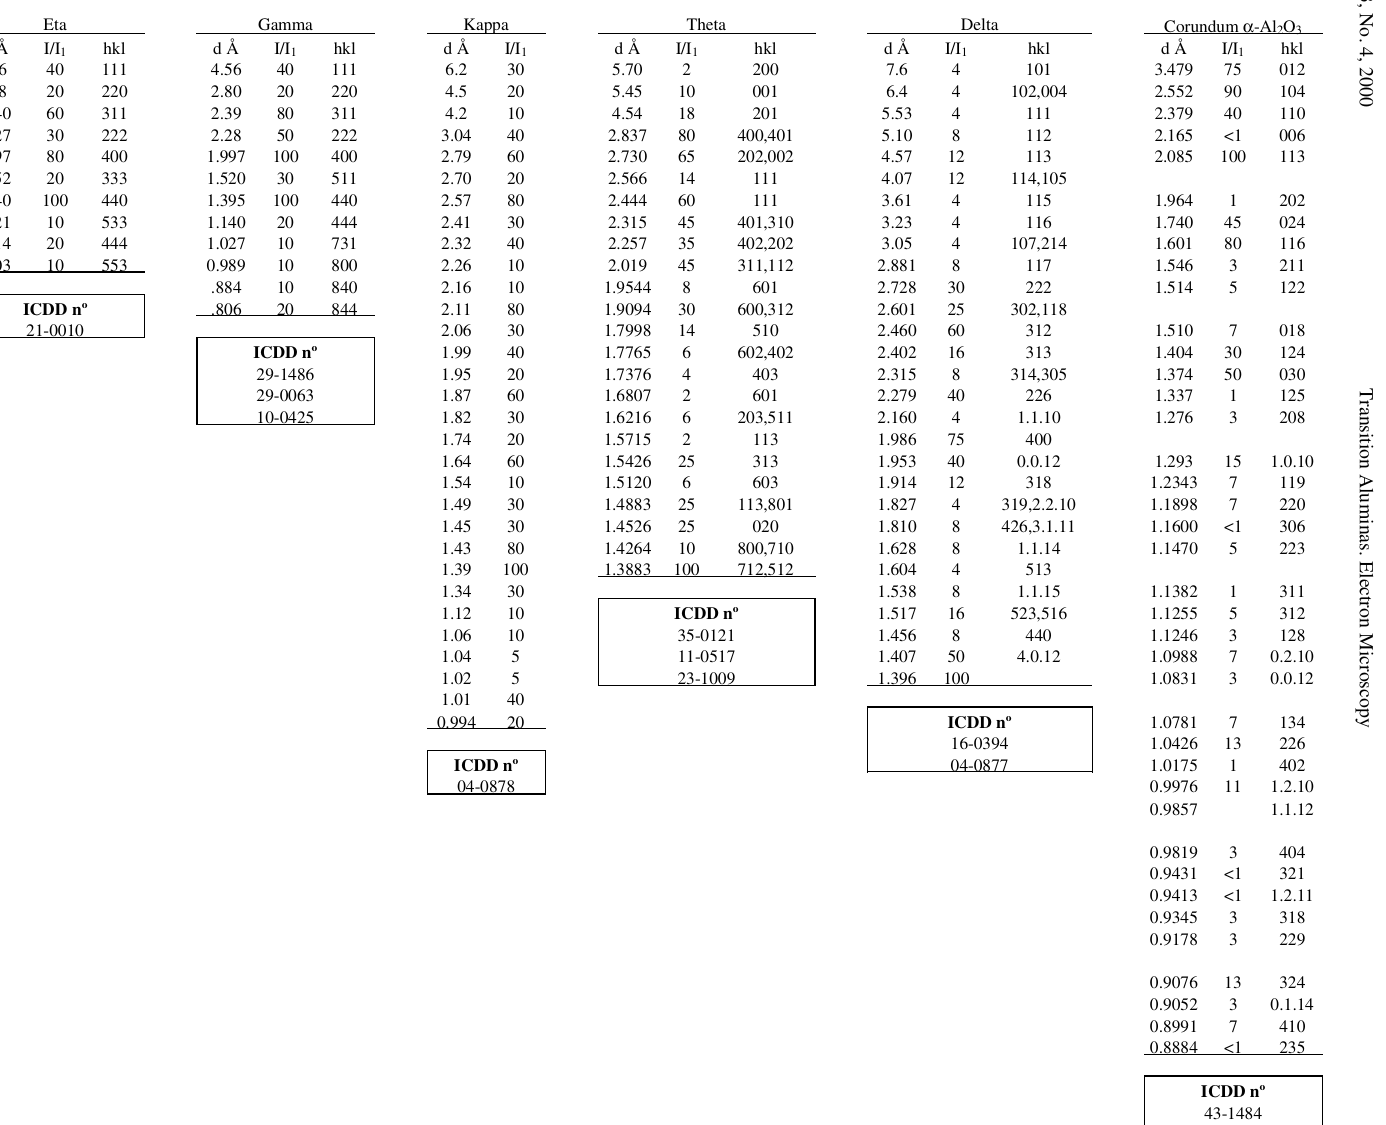
Table 1. X-ray diffraction data of transition aluminas and